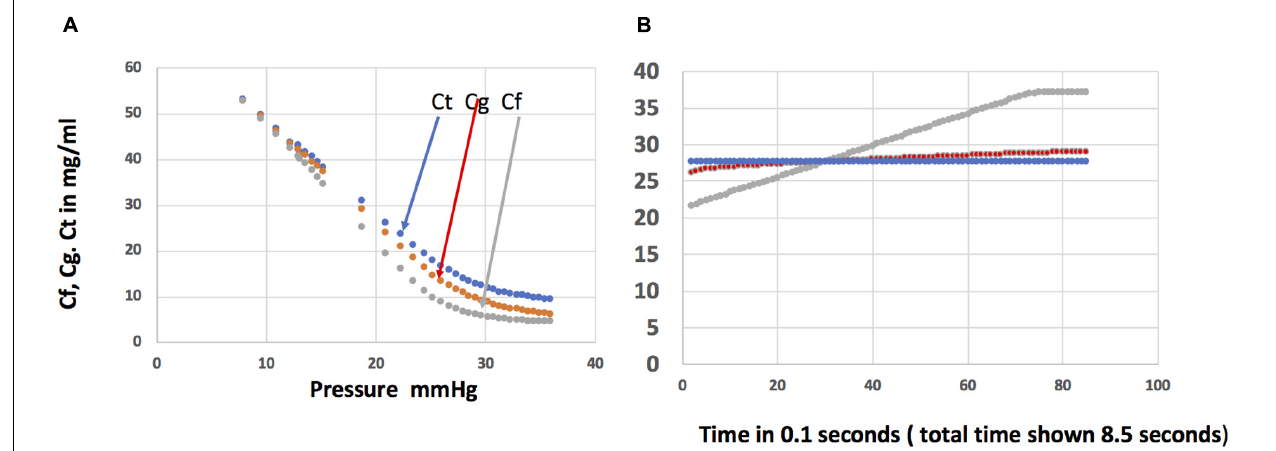
FIGURE 5 | Panel (A) shows the steady state concentrations in the fluid in the sub-compartment Cf (gray), the sub-compartment between the base of the glycocalyx and the tissue sub-compartment Cg (red), and in the tissue sub-compartment Ct (blue) as a function of pressure when the barriers behind the glycocalyx account for 7% of the total resistance to exchange across the glycocalyx-endothelial cleft pathway (PdS2 = 5.6 ml/min; PdS1 = 0.4 ml/min). Panel (B) shows the time course of changes in the concentrations in each of the three sub-compartments as pressure is reduced in steps of 0.1 mmHg each 0.1 s from a steady state at P = 20 mmHg to a pressure of 13 mmHg after 7 seconds. A detailed analysis of the magnitude and direction of diffusion and convective transport of protein fluxes as pressure is reduced is in the